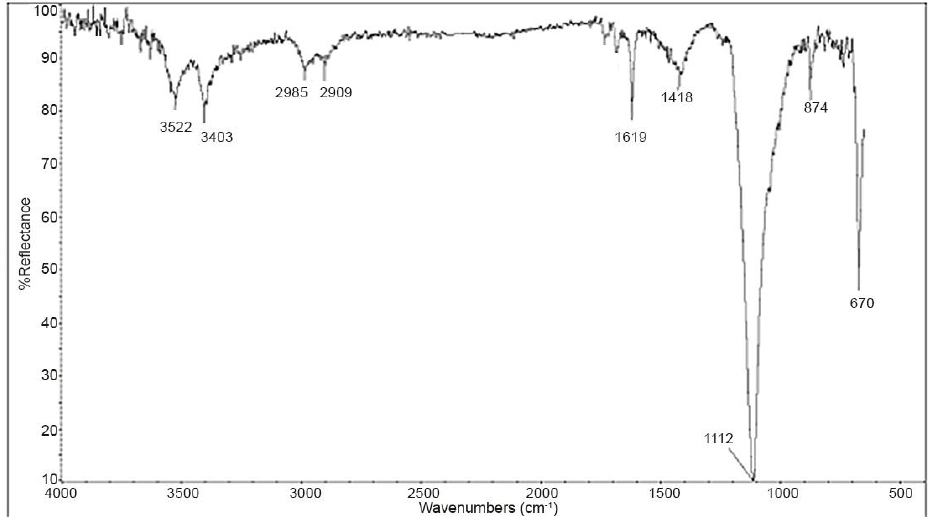
Figure 12. FTIR spectrum of the superficial part of sample B1 (blue sample taken from the robe of St. Andrew).